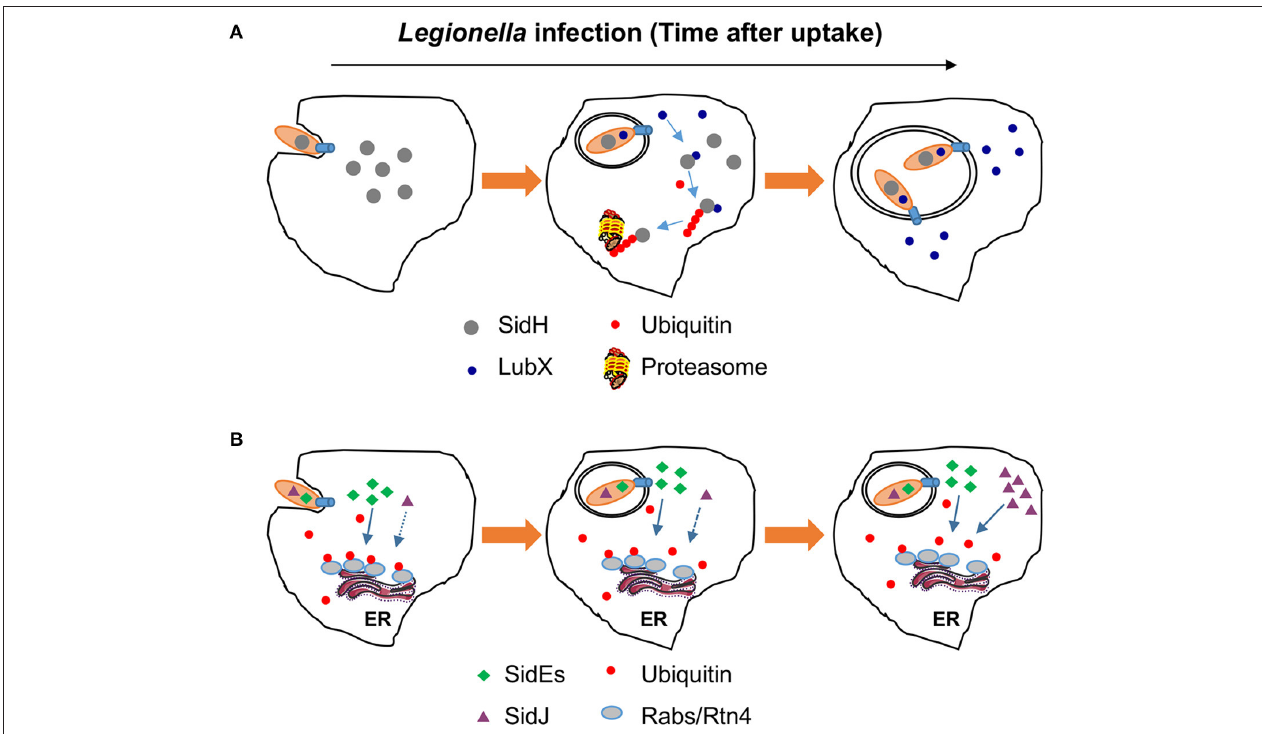
FIGURE 2 | Temporal regulation of effector activity by effectors. (A) Regulation of SidH by LubX. The expression of lubX does not become apparent until after several hours postinfection. This ubiquitin E3 ligase functions with the host machinery to ubiquitinate SidH, resulting its degradation by the proteasome. (B) Regulation of SidEs by SidJ. SidEs catalyze the ubiquitination of RTN4 or ER-associated Rab small GTPases such as Rab33b whereas SidJ reverses such modification by its phosphodiesterase activity. In the early phase of infection, the ratio between translocated SidEs and SidJ favors ubiquitination of relevant substrates, which is beneficial for the biogenesis of the LCV. Several hours after bacterial uptake, the activity of SidJ becomes dominant due to higher amount of translocated protein, which reverses the ubiquitination imposed by the